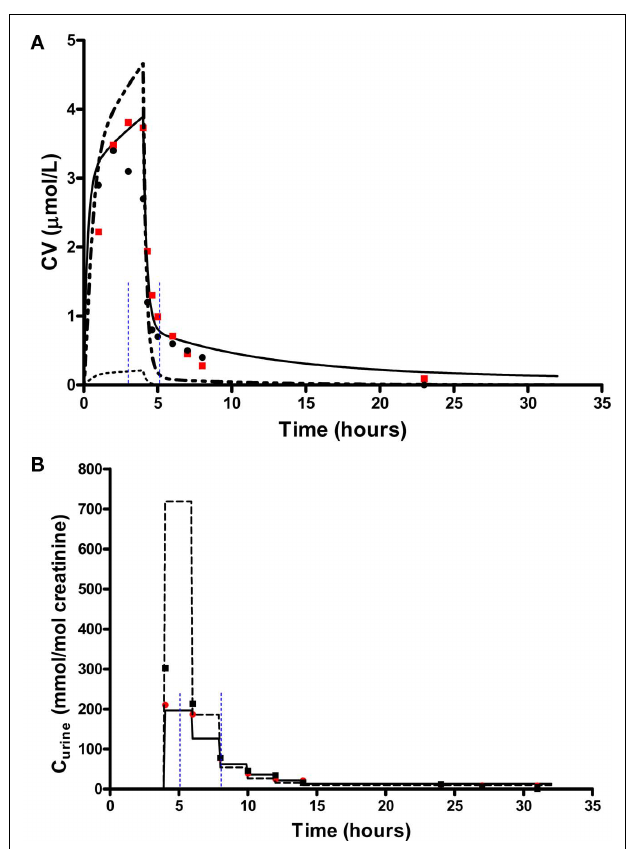
FIGURE 2 | Simulation of venous blood m -xylene and urinary excretion of methylhippuric acid (expressed against creatinine). The symbols are typical measured values from two volunteers and the solid lines are model predictions using mean point values for anatomical, physiological and biochemical parameters for, (A) CV and (B) C urine . In panel (A) the lower broken line shows the region of approximate total variance.The upper broken line is the approximate total variance multiplied by 25 in order to show more clearly the relationship to model prediction.The short broken lines at 3 and 5h in panel (A) and 5 and 8h in panel (B) show the time slices chosen for eFAST